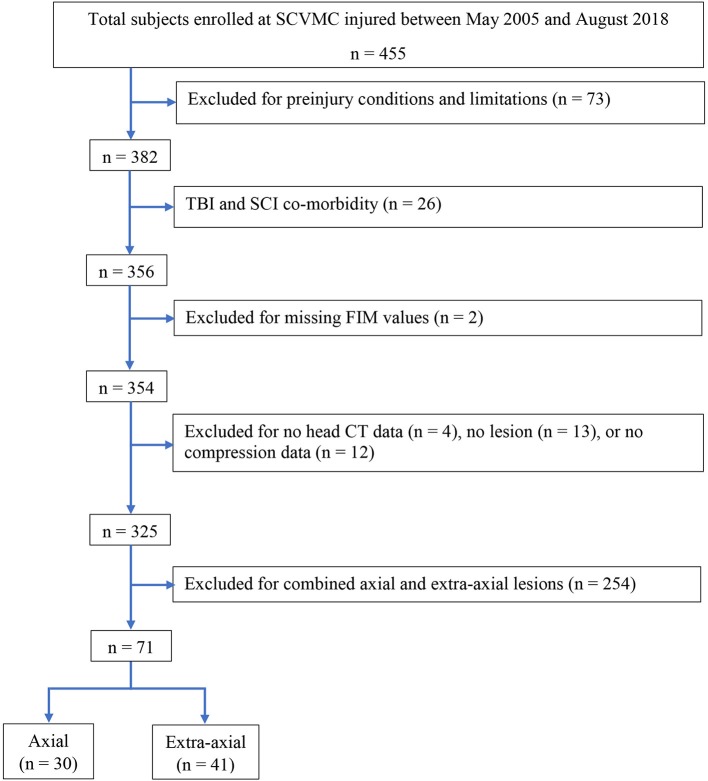
Flowchart of the study participants.